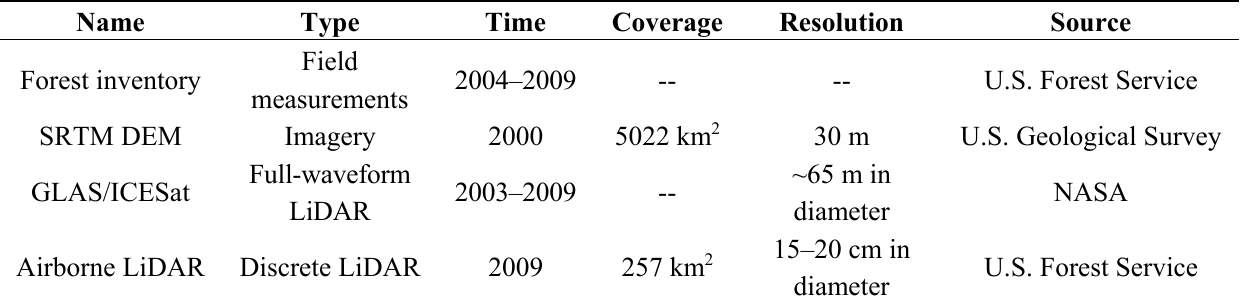
Table 1. Characteristics and data sources of the seven collected datasets in this